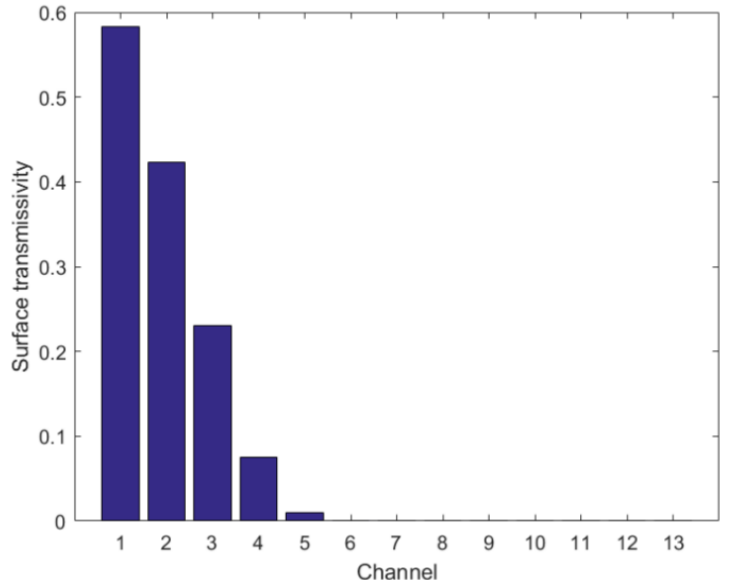
Figure 1. The mean value of the surface transmissivity for each channel of MWTS-II. It can be observed from Figure 1 that the mean values of the surface transmissivity for MWTS-II channels 1–5 with peak WF heights distributed in the middle and lower atmosphere are not zero, and the closer the peak WF height is to the surface, the greater the mean value of the surface transmissivity. The mean values of the surface transmissivity for MWTS-II channels 6–13 with peak WF heights distributed in the upper atmosphere are zero. Thus, MWTS-II channels 1–5 with non-zero mean values of the surface transmissivity are sensitive to SSP, while MWTS-II channels 6–13 with zero mean values of the surface transmissivity are not. and the atmospheric temperature, humidity, and surface parameters are linked in natural climate [33,45]. Therefore, the observations of MWTS-II channels may be correlated. The correlation coefficients between the observations of channels with zero Y ( P S , 0 ) and chan- nels with non-zero Y ( P S , 0 ) are calculated using the analysis dataset, and the calculated correlation coefficients are shown in Table